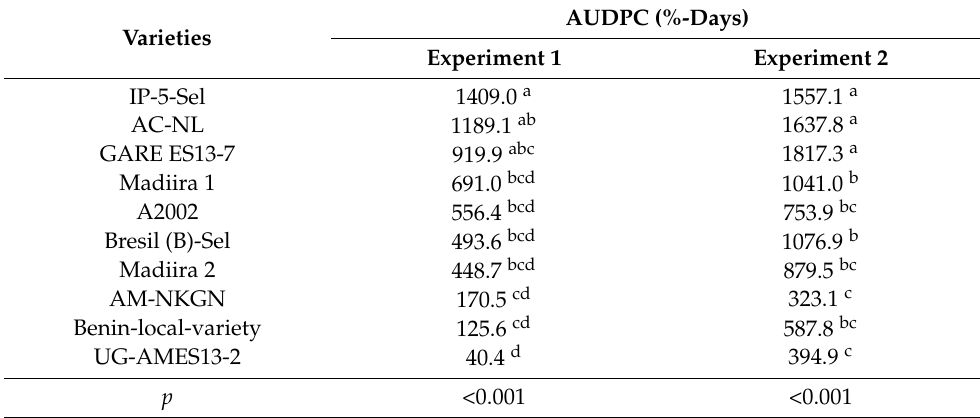
Table 8. Area under the disease progress curve (AUDPC) for bacterial wilt incidence on cut plants of amaranth varieties in the